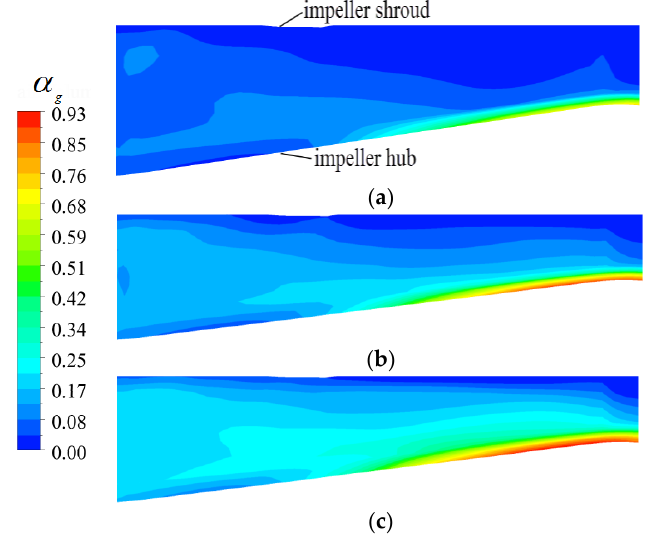
Figure 9. Distribution of gas void fraction along the streamwise direction at different IGVF s. ( a ) IGVF = 9%; ( b ) IGVF = 15%; ( c ) IGVF = 21%.